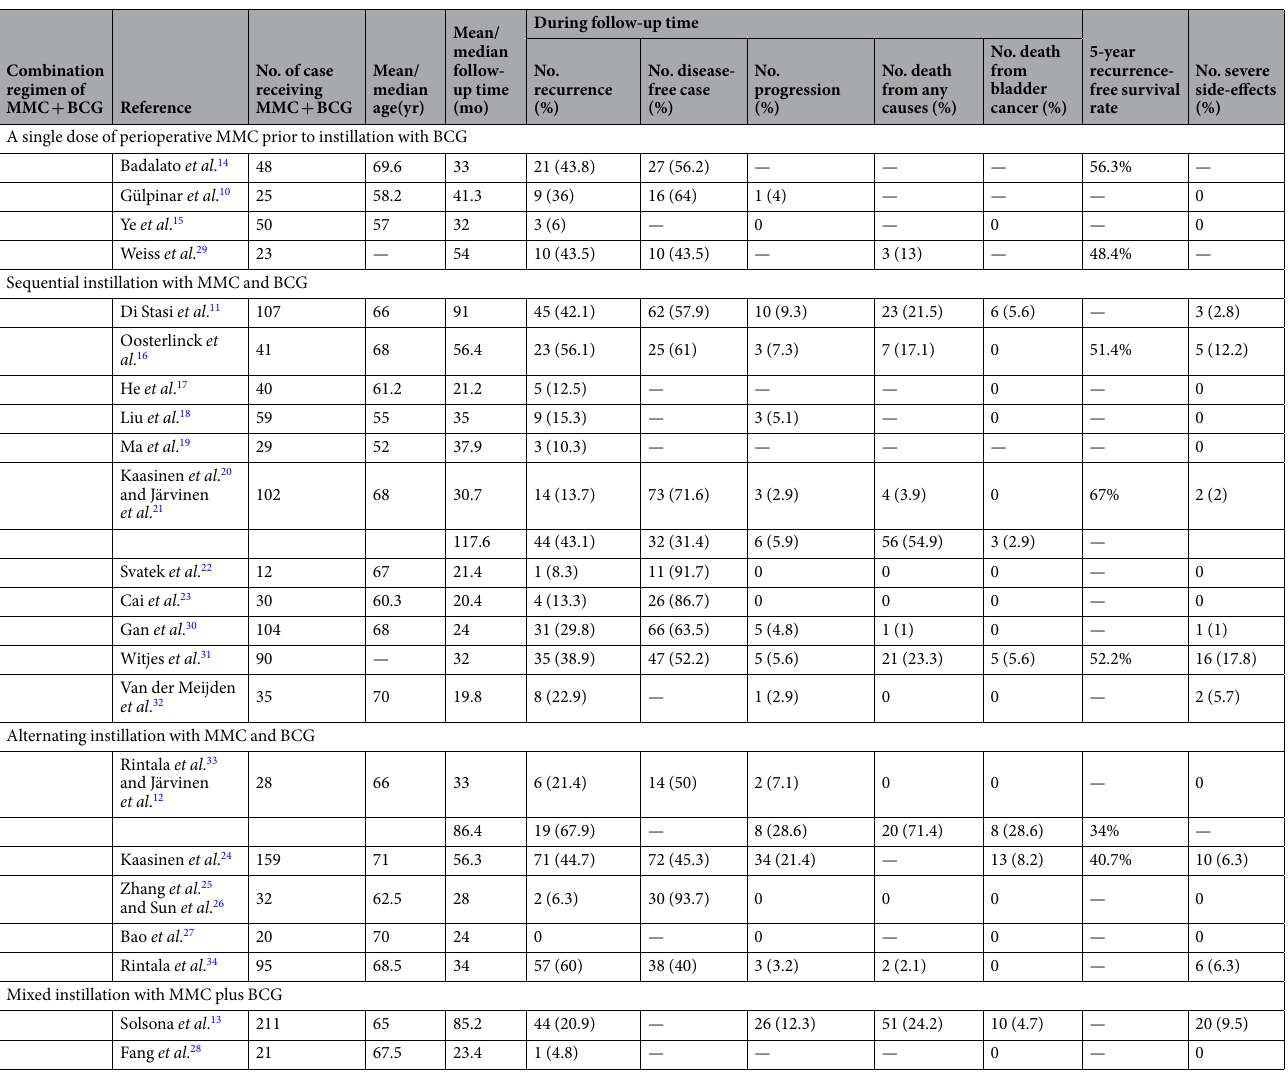
Table 2. Detailed outcomes of patients receiving combination therapy. BCG = bacillus Calmette-Guerin; MMC = mitomycin